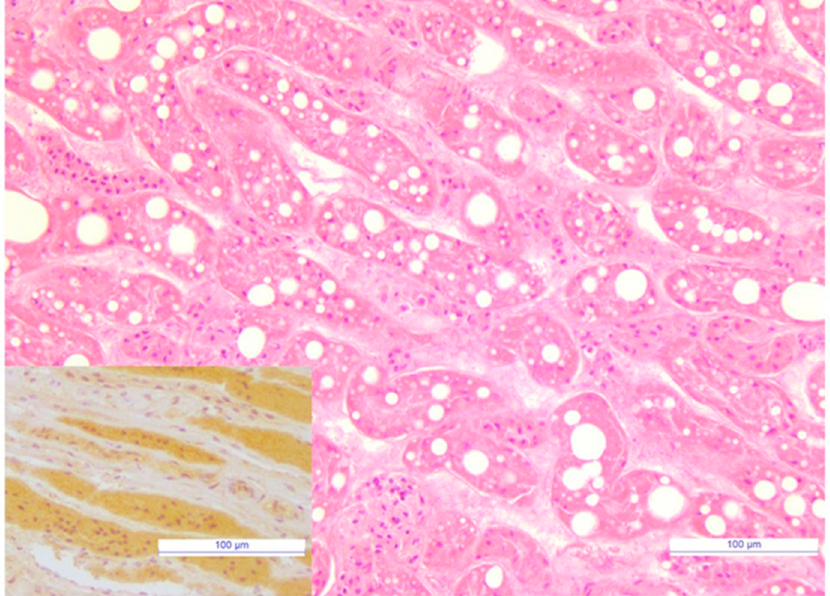
Figure 1. Cat, Kidney. Diffuse lipidosis of cortical tubular epithelial cells. H&E, Bar = 100 µm. Inset: Cat, Kidney. Tubular structures of medulla showed strong and diffuse immunoreactivity for FeMV. IHC, Mayer’shaematoxylincounterstain, Bar = 100 µm.